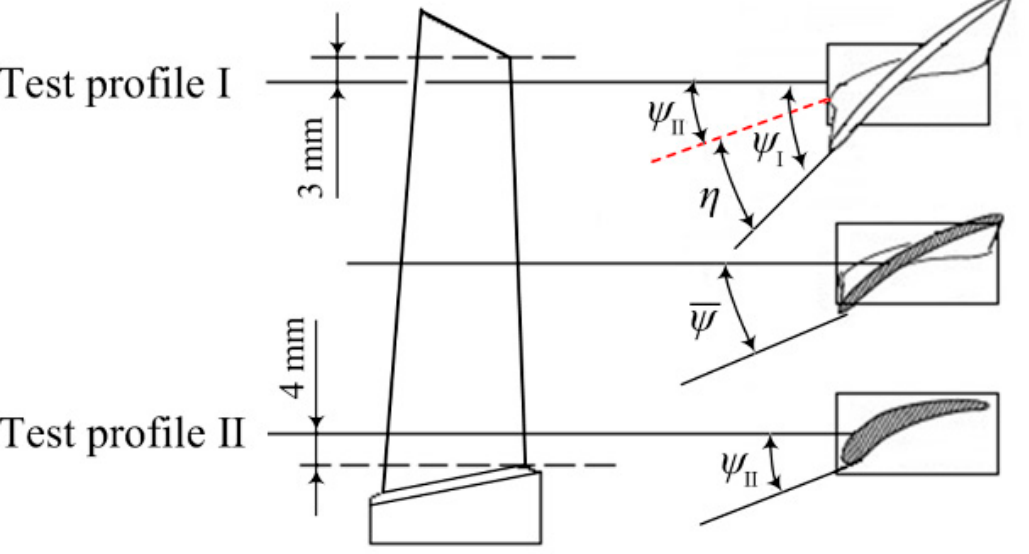
Figure 2. Model of characterization and evaluation for blade twist.